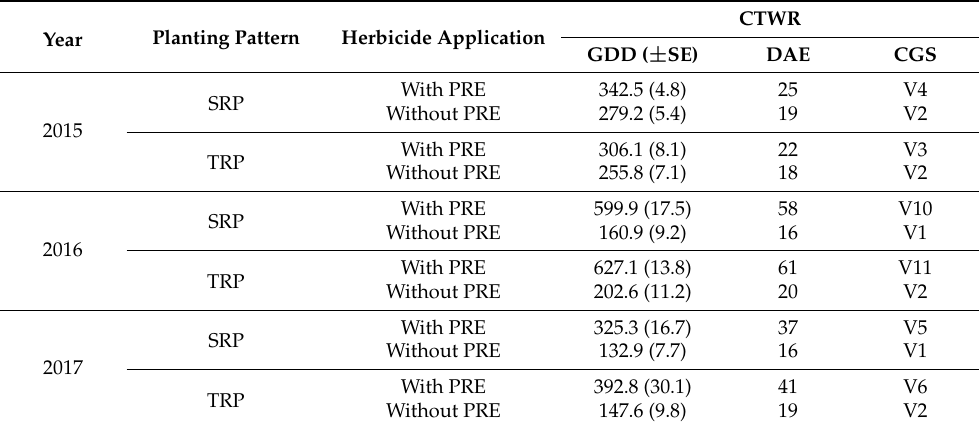
between the upper and lower limits (also known as inflection point). Table 6. The CTWR (based on a 5% acceptable yield loss) influenced by planting pattern and two levels of herbicide application in corn grown without PRE herbicide and with PRE herbicide expressed in growing degree days (GDD), corresponding crop growth stage (CGS), and days after emergence (DAE). Year Planting